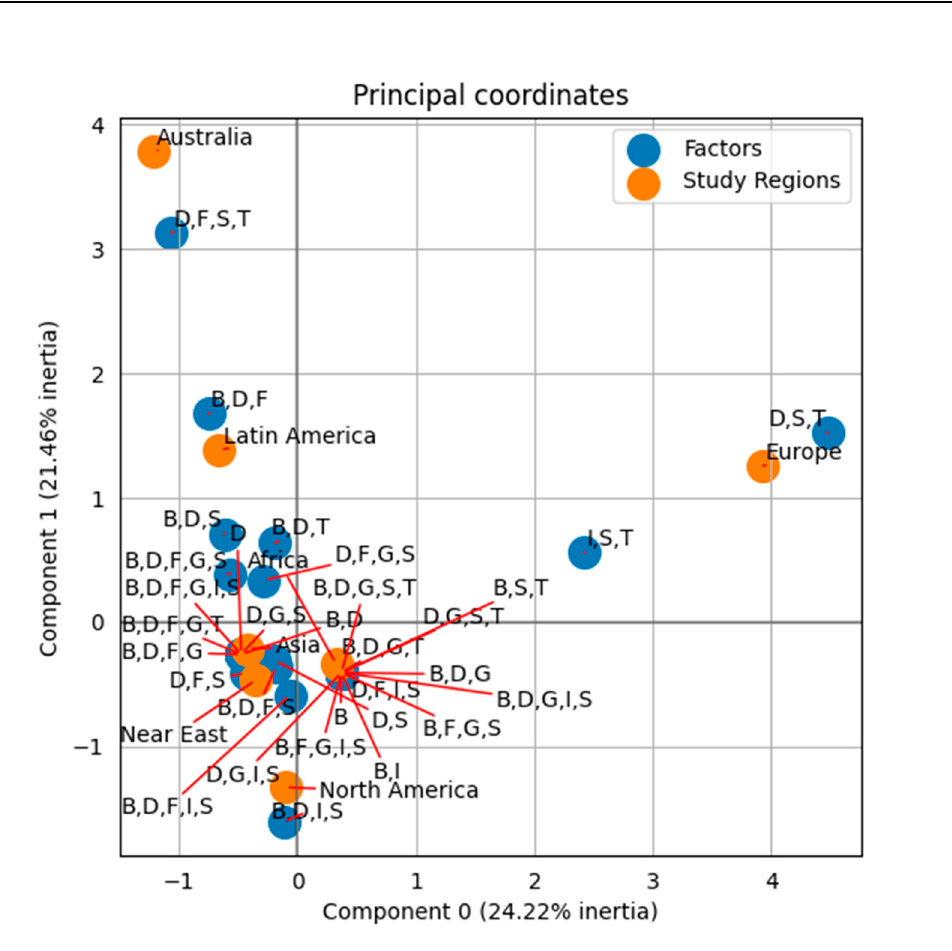
Figure 13. 2-D Correspondence Analysis biplot of Study Regions and Factors affecting Irrigation Adoption.